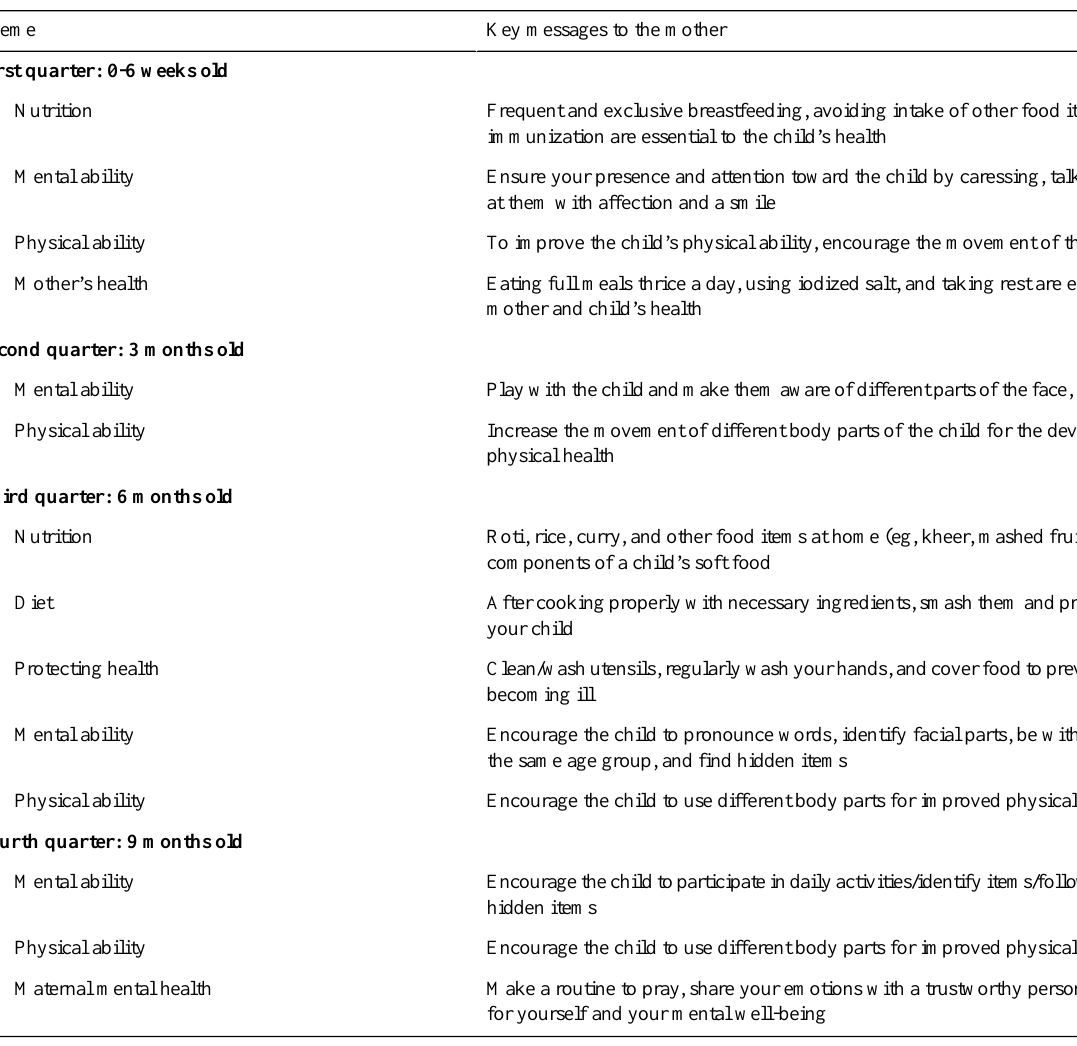
Table 1. Key counseling messages and their delivery time for the intervention arm according to child age. First quarter: 0-6 weeks old